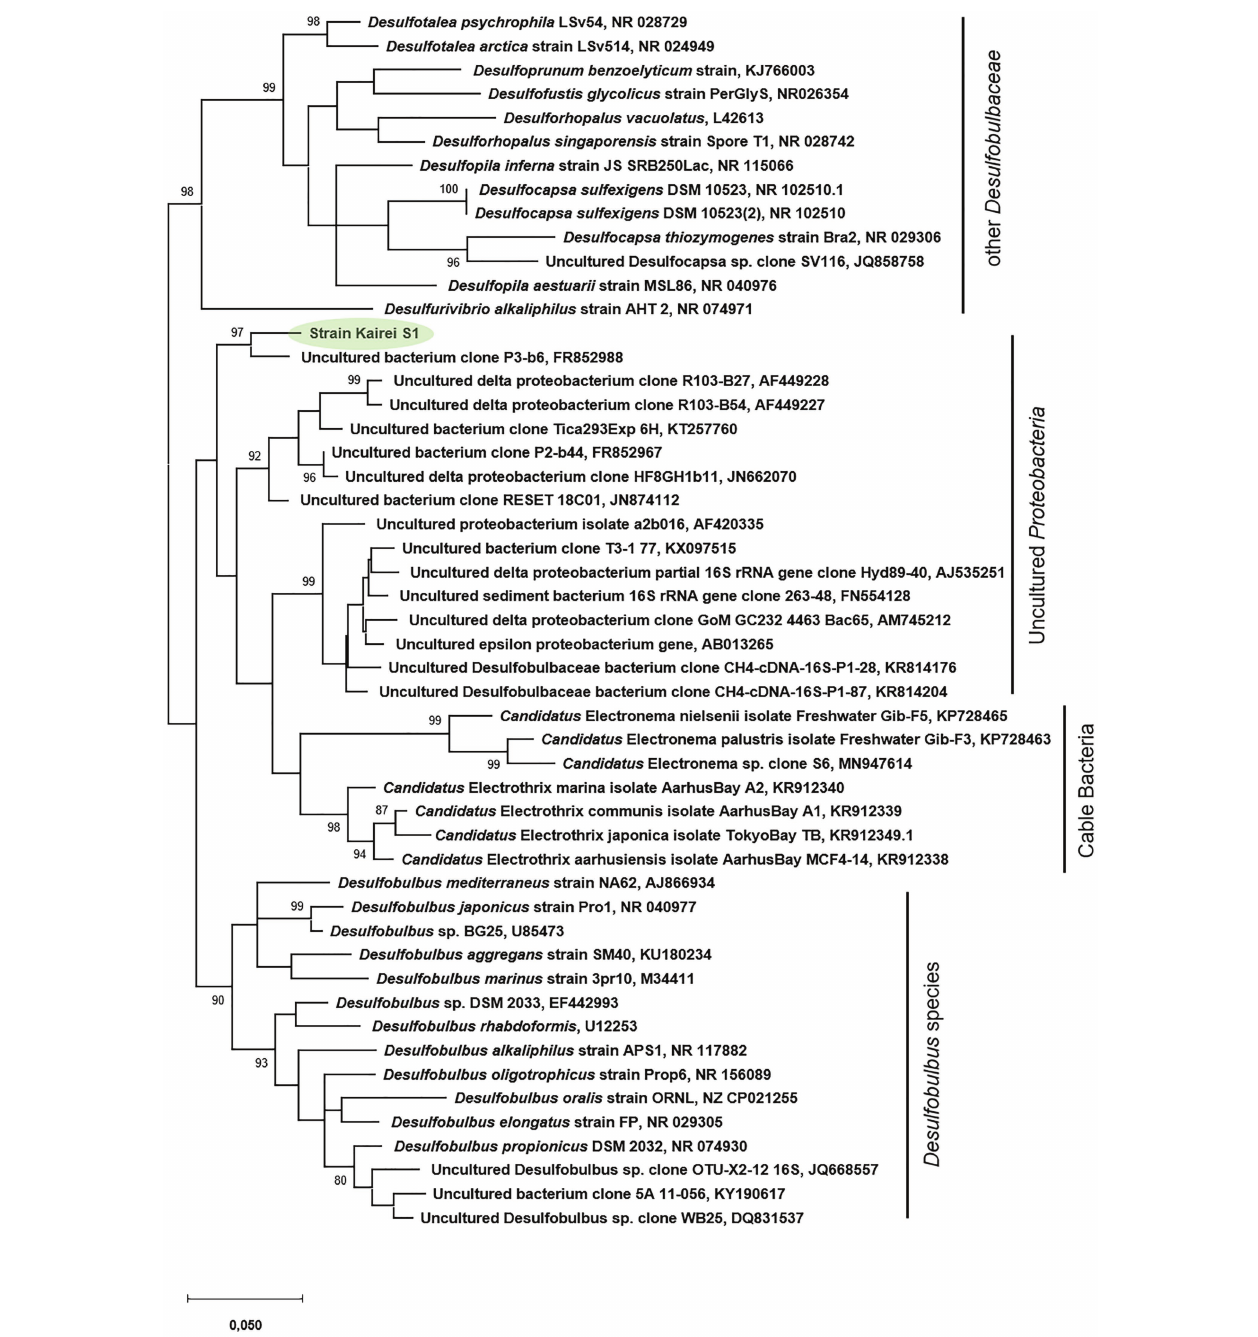
FIGURE 1 | Phylogenetic relationship of 16S rRNA gene sequences of strain KaireiS1 and its closest relatives. Bootstrap values are only displayed if above 80%. The scale bar represents the expected number of changes per nucleotide